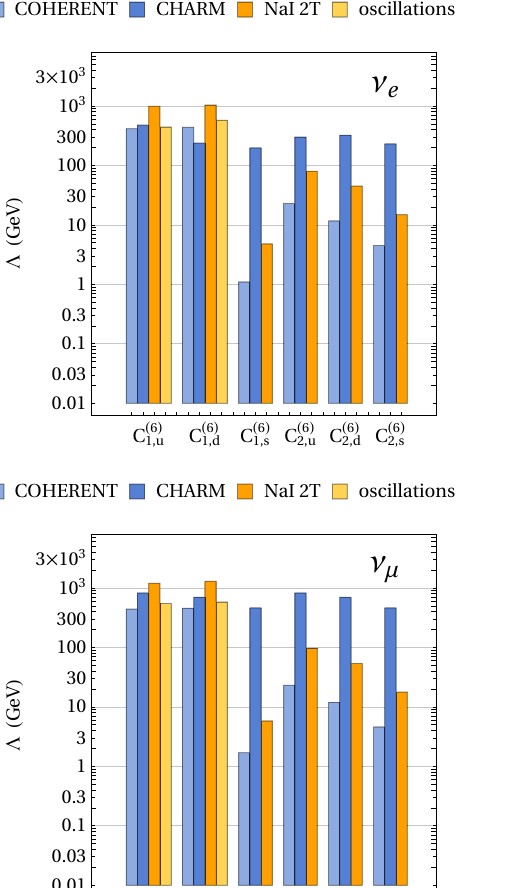
, i = j i → ν j (cid:30)